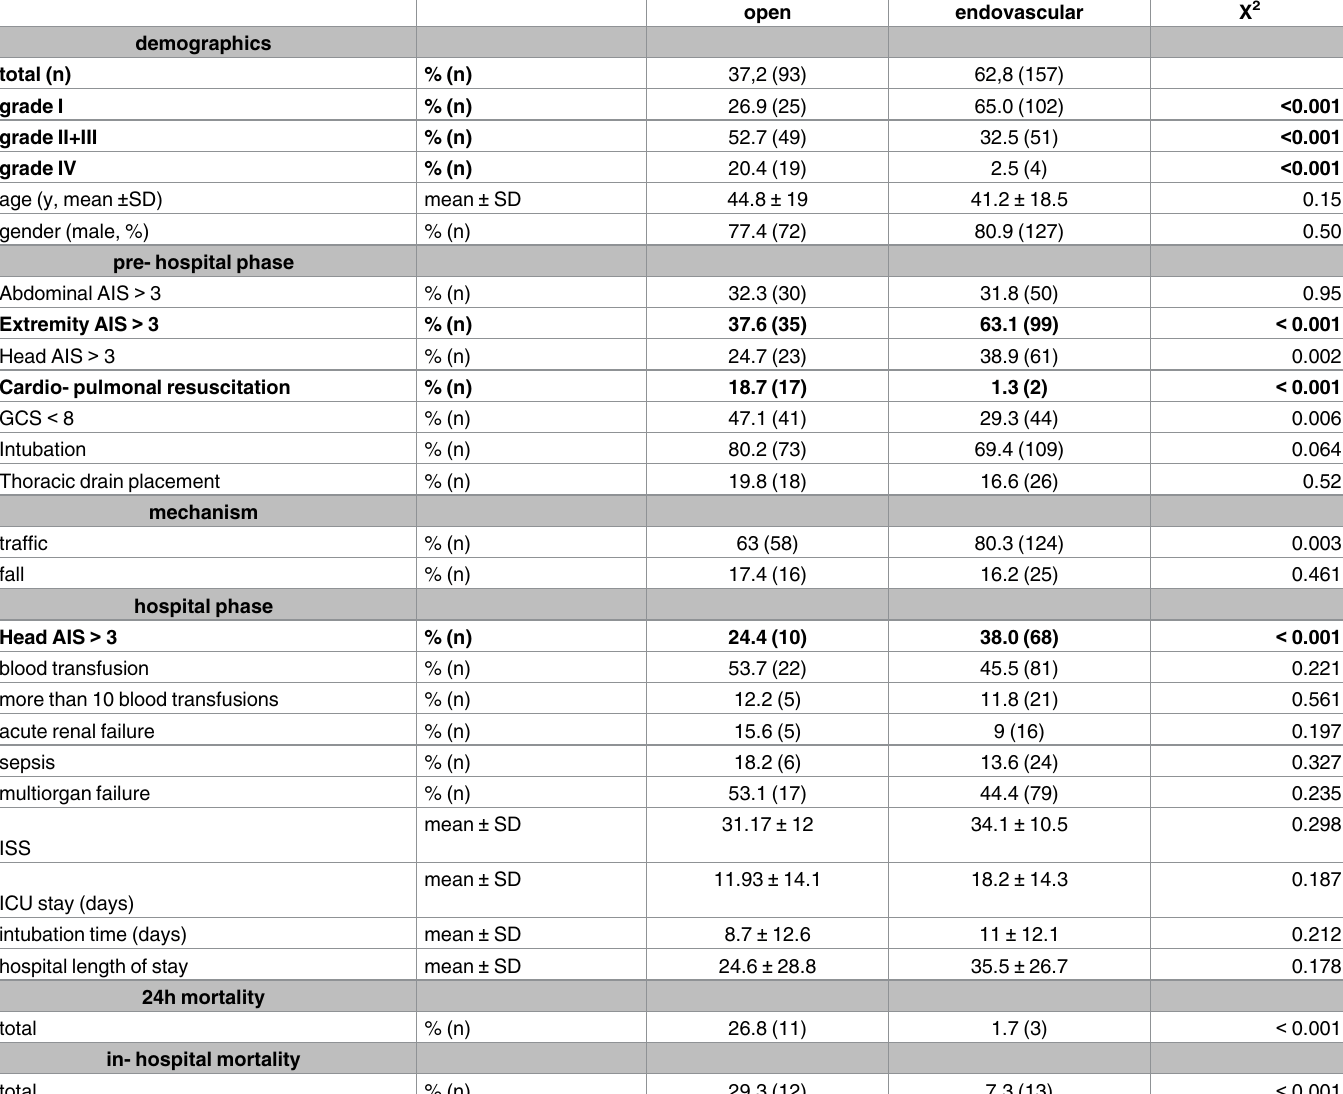
Table 3. Comparison of the open surgical and endovascular treatment